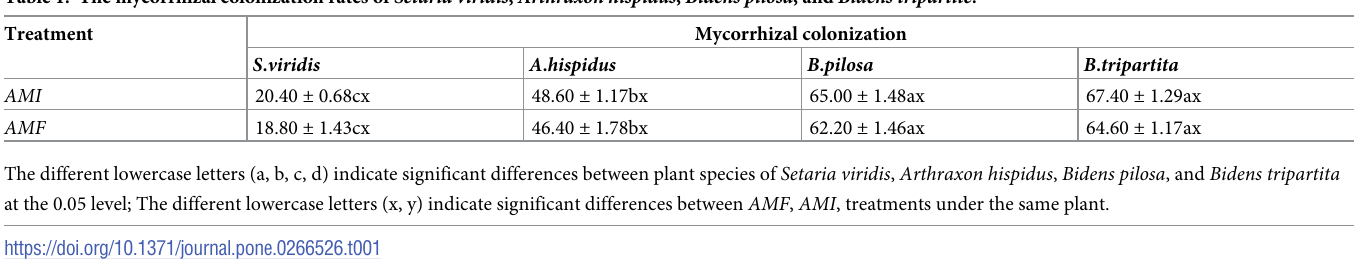
Table 2. Two-way ANOVAs for the effects of plant species (S. viridis vs . A . hispidus vs . B . pilosa vs . B . tripartita ) and soil microbial condition ( AMF vs . AMI vs . CK ) on the biomass, the N accumulation, and their response ratio (ln R ). Factors